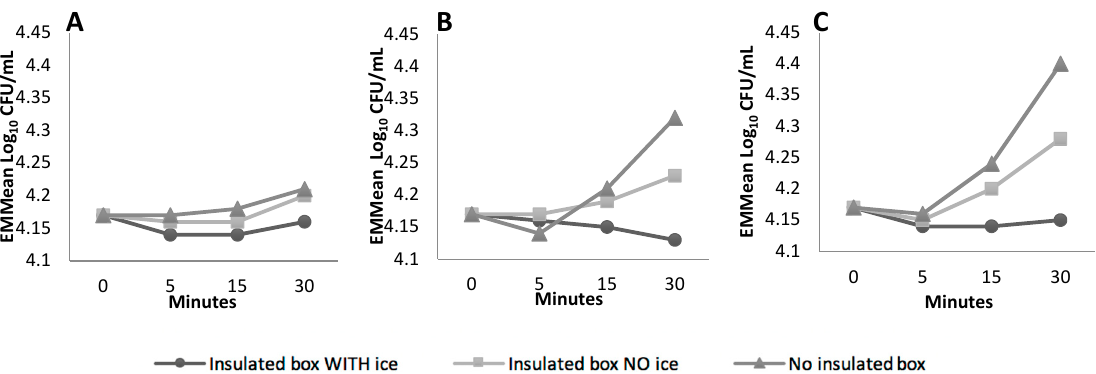
Figure 1. Estimated Marginal Means (EMM)eans of pathogen concentration under various storage types at 20 °C ( A ), 30 °C ( B ) and 40 °C ( C ) over 30 min, statistically controlling for pathogen species and pathogen inoculum level factors.